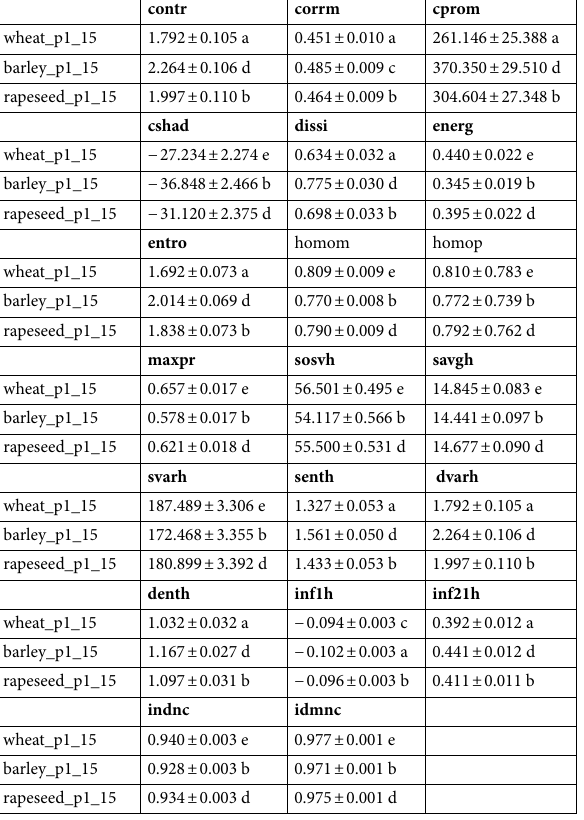
Table 3. Texture analysis of kernels while measuring selected air stream velocities (15 m s −1 ) and the position of the seed-air tube type I. a–e: the differences between mean values with the same letter in columns were statistically insignificant ( p <